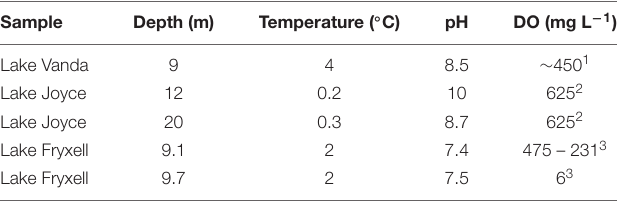
TABLE 2 | Physicochemical conditions in the investigated Antarctic